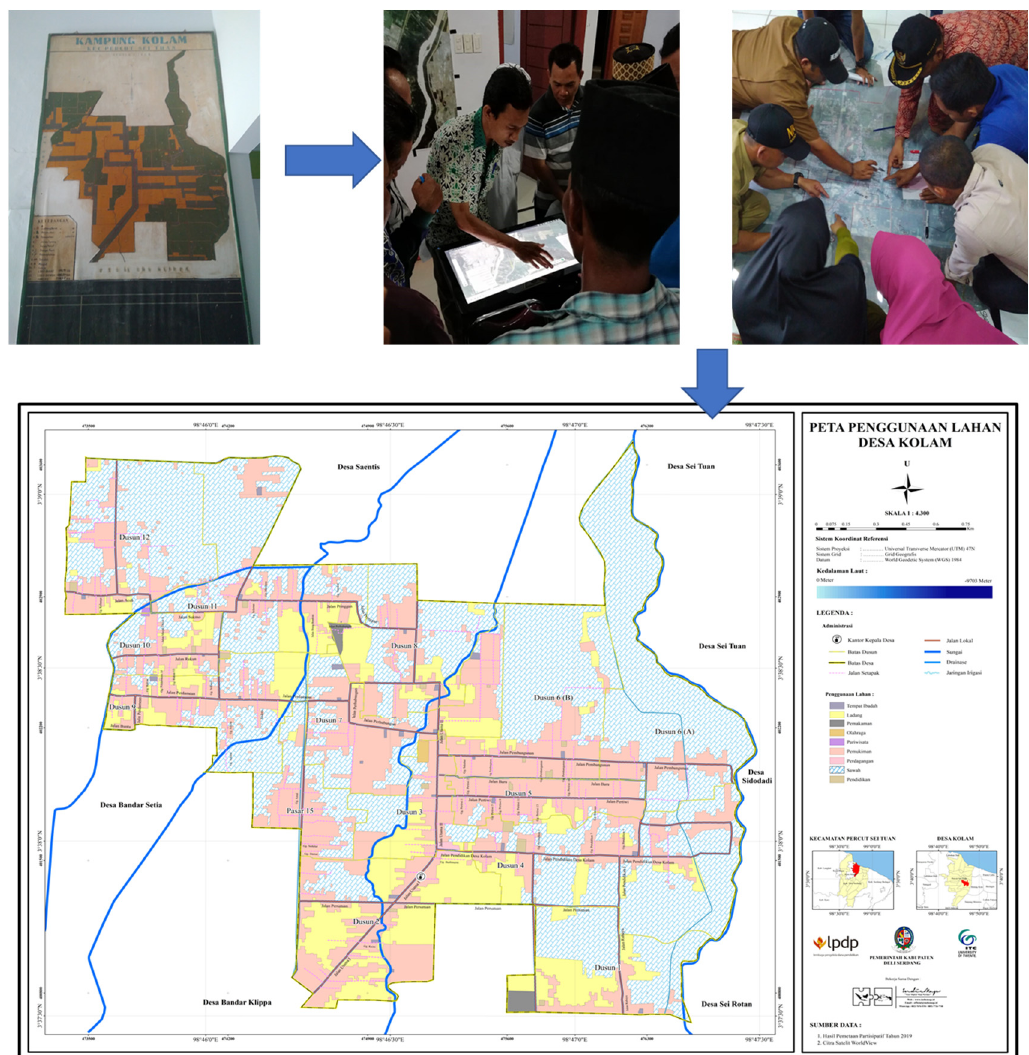
Figure 2. The participatory village map-making process, from a sketch map, created during digital or non-digital participatory mapping workshops, to a (georeferenced) village map.